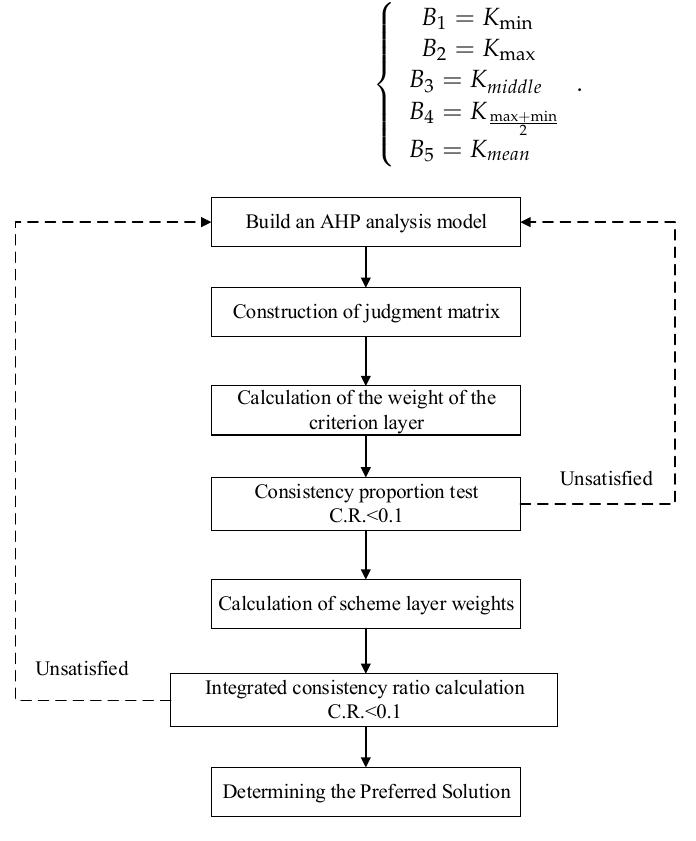
Figure 10. Calculation process of AHP.